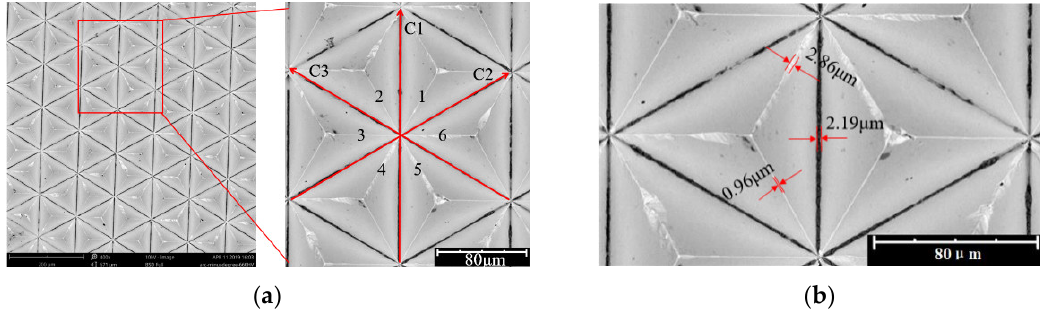
Figure 7. SEM (scanning electron microscope) of the burr and invalid zone: ( a ) Edge burrs, ( b ) Measurement of the invalid zone of the texture unit.